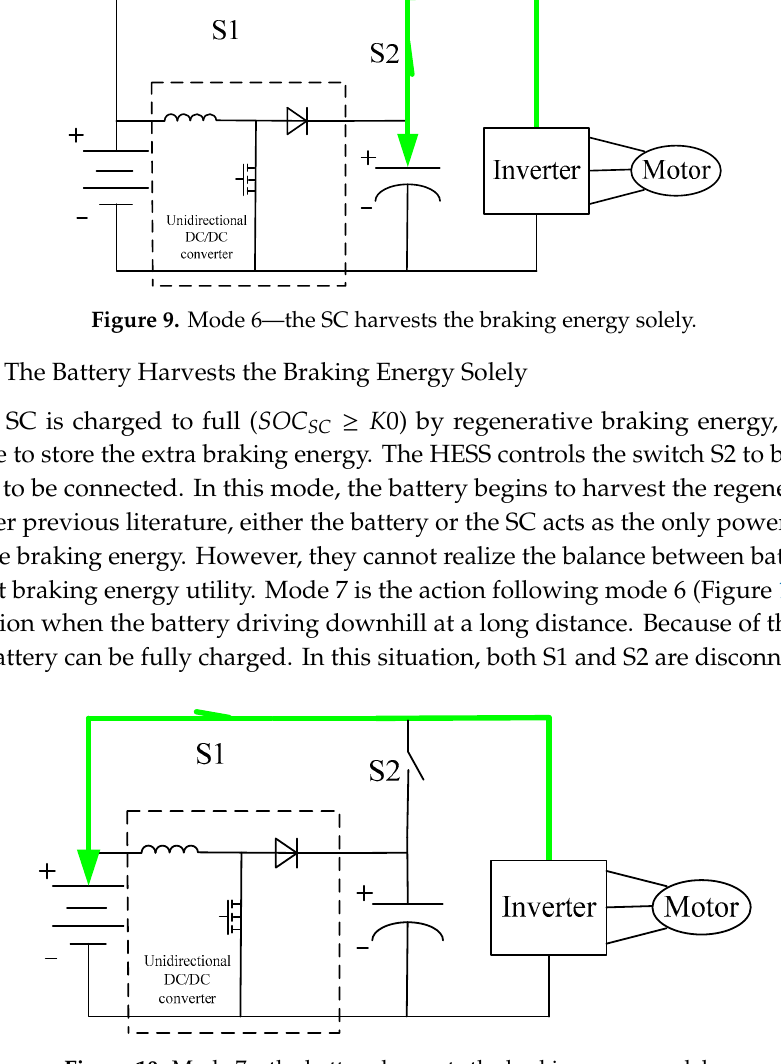
Figure 10. Mode 7—the battery harvests the braking energy solely.